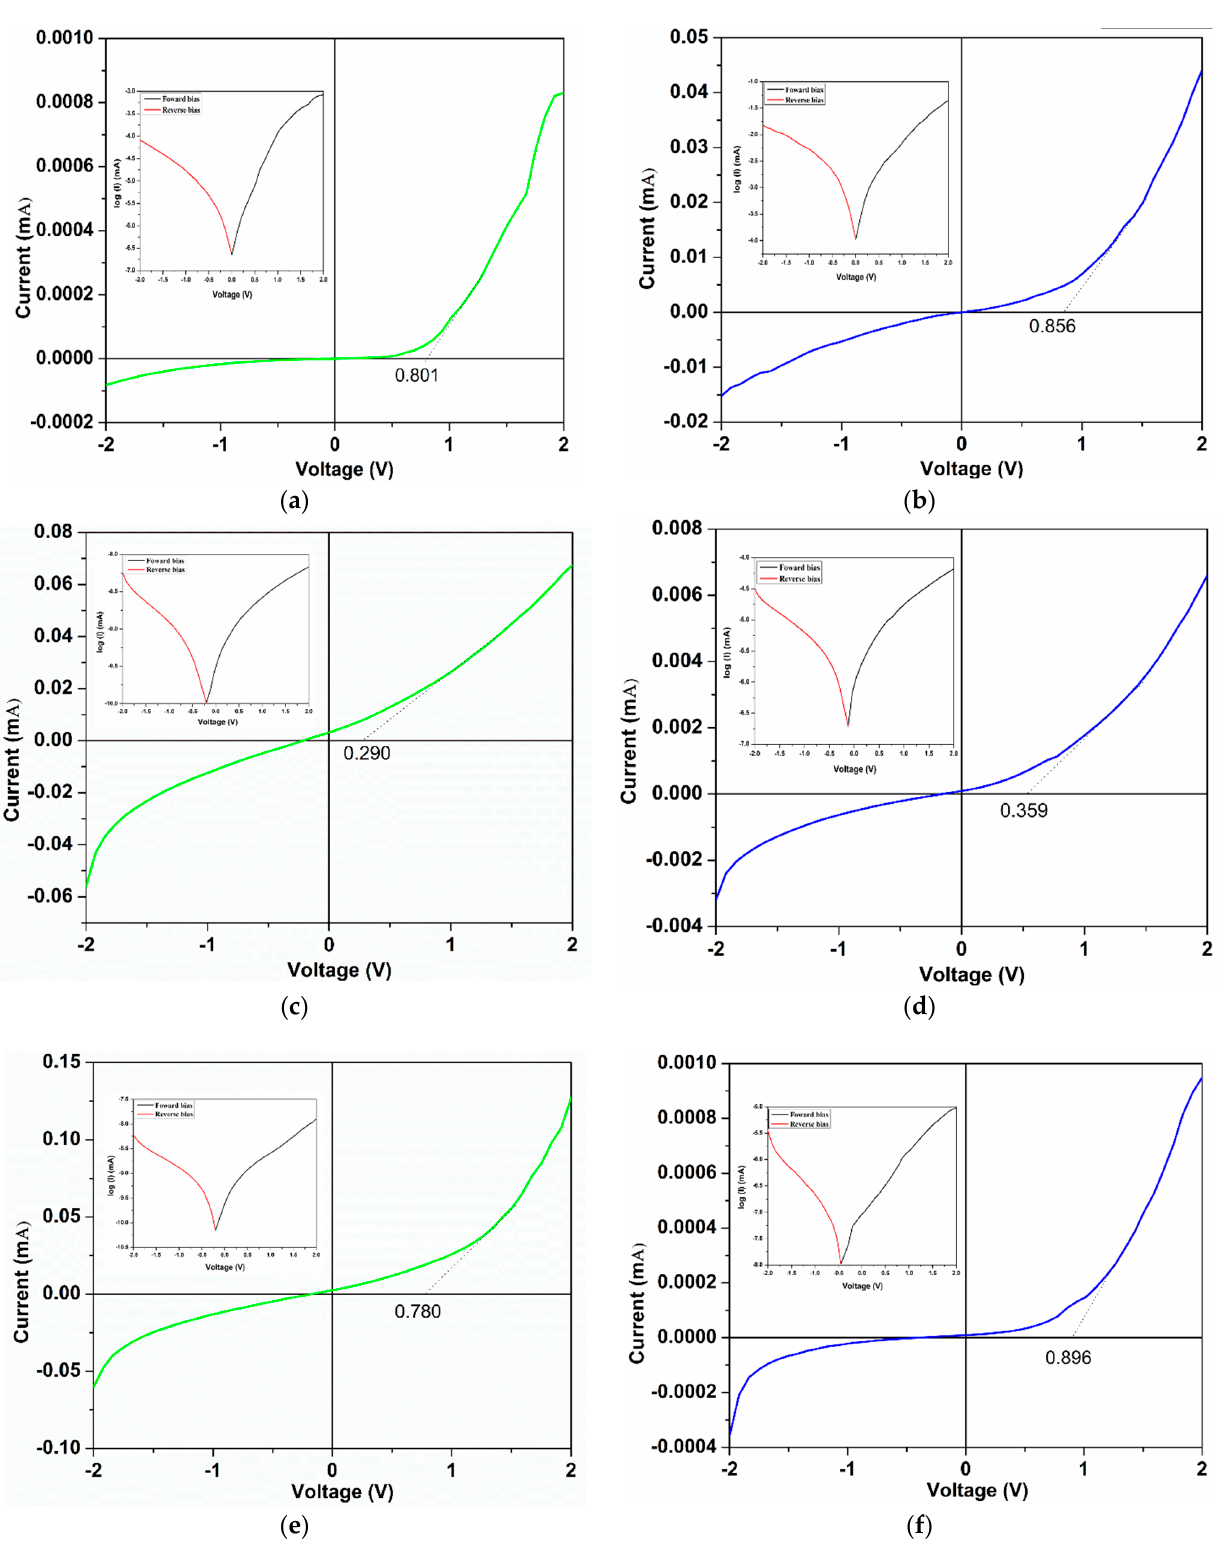
Figure 7. Current-voltage characteristics of the as-obtained sensors ZnO Nw2 @CMO ( a ); ZnO Nw3 @CMO ( b ); ZnO Nw4 @CMO ( c ); ZnO Nw5 @CMO ( d ); ZnO Nw6 @CMO ( e ); ZnO Nw7 @CMO ( f ) and Inset: Log (I)–V plot from forward and reverse bias.